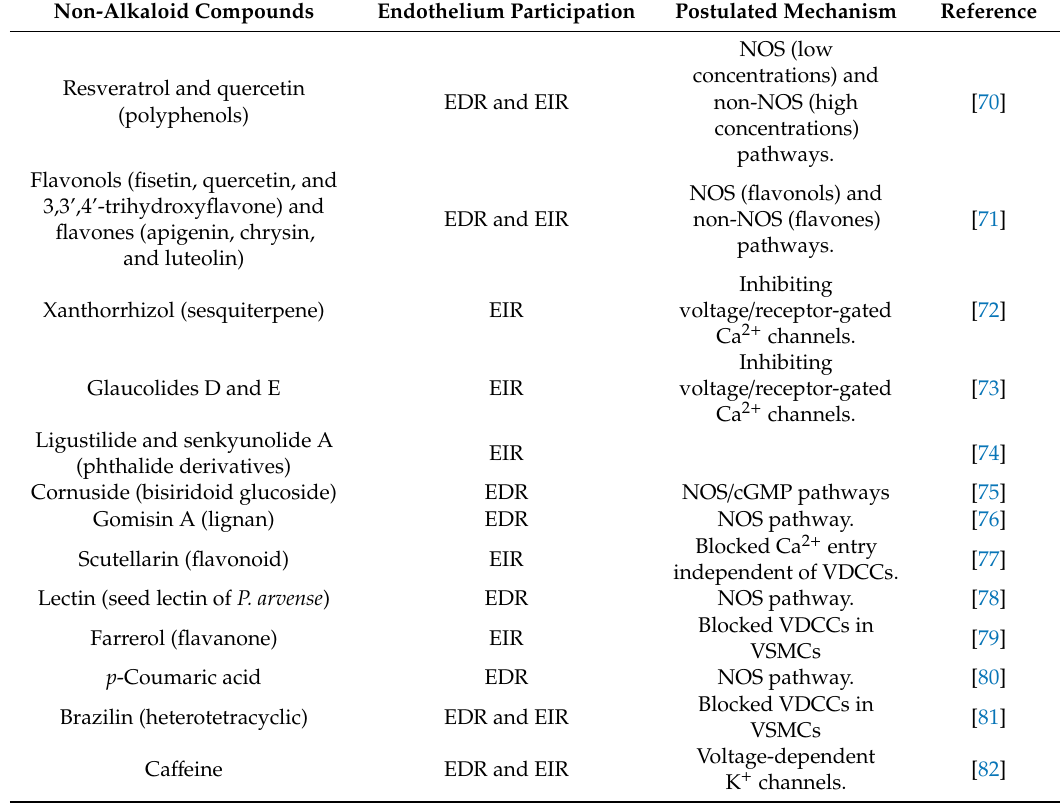
Table 3. Summary of vasodilator e ff ects induced by alkaloids in isolated rat aorta (IRA). Non-Alkaloid Compounds Endothelium Participation Postulated Mechanism